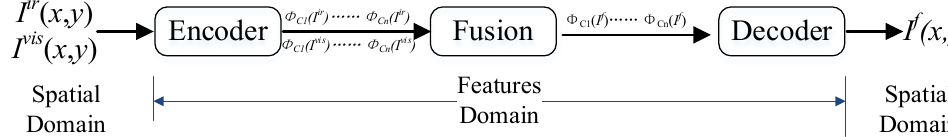
Figure 1. The framework of domain transform for IR and visible images fusion.